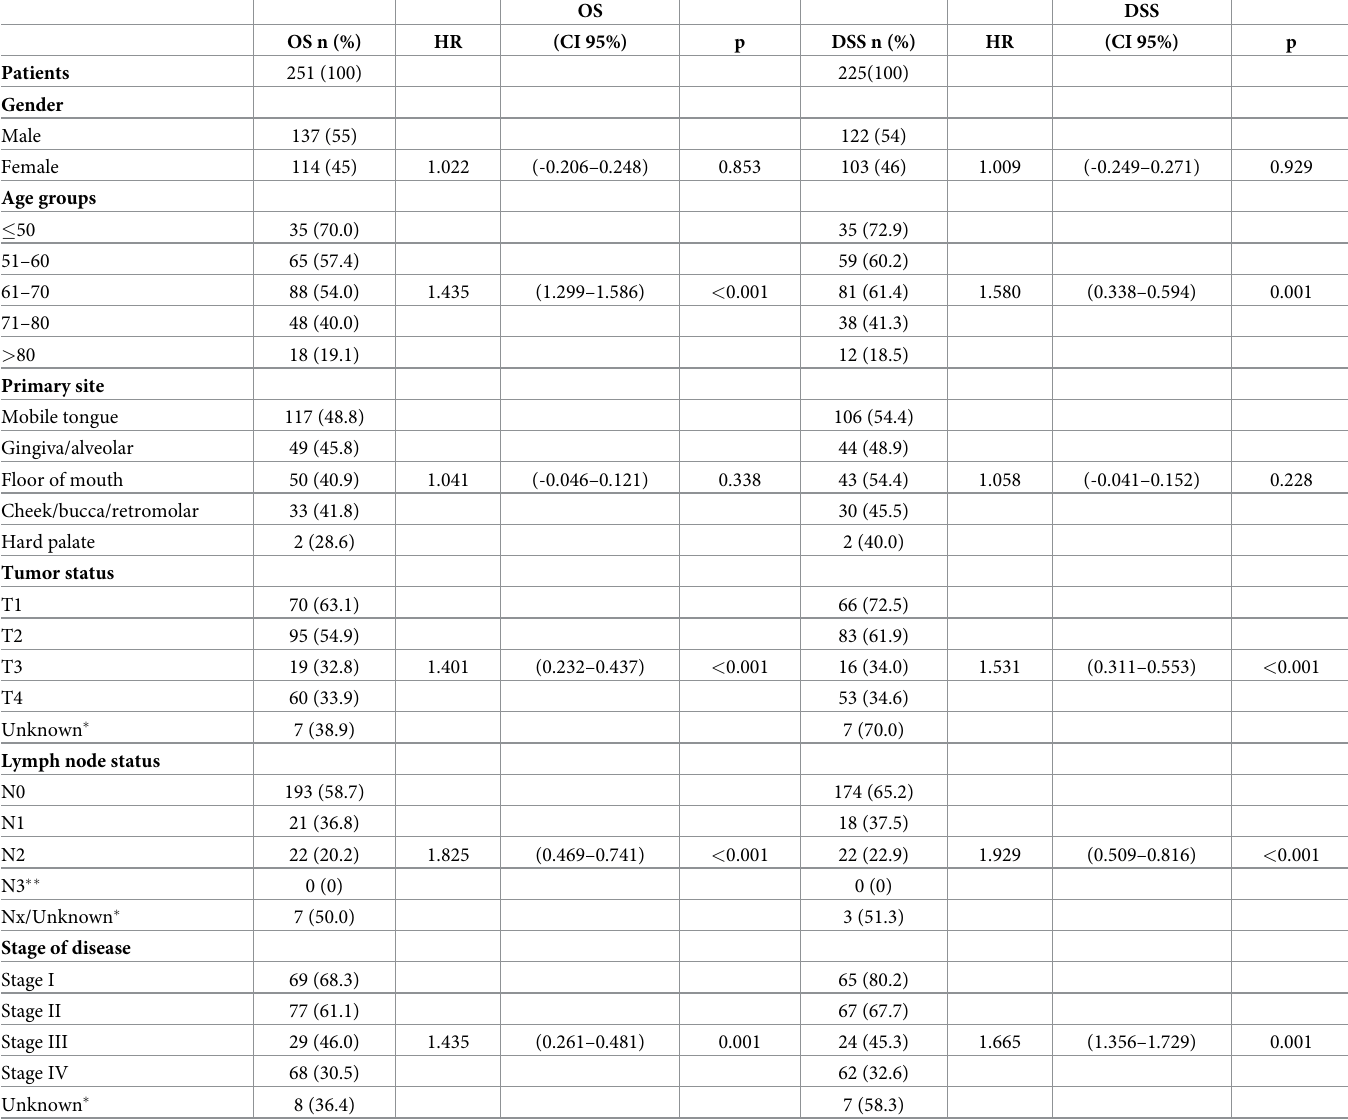
Table 4. Clinicopathological characteristics and five-year overall survival and disease-specific